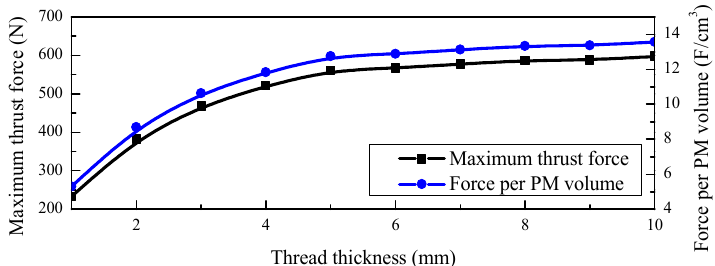
Figure 10. The maximum thrust force and force per PM volume when the thread thickness varies from 1 to 10 mm.